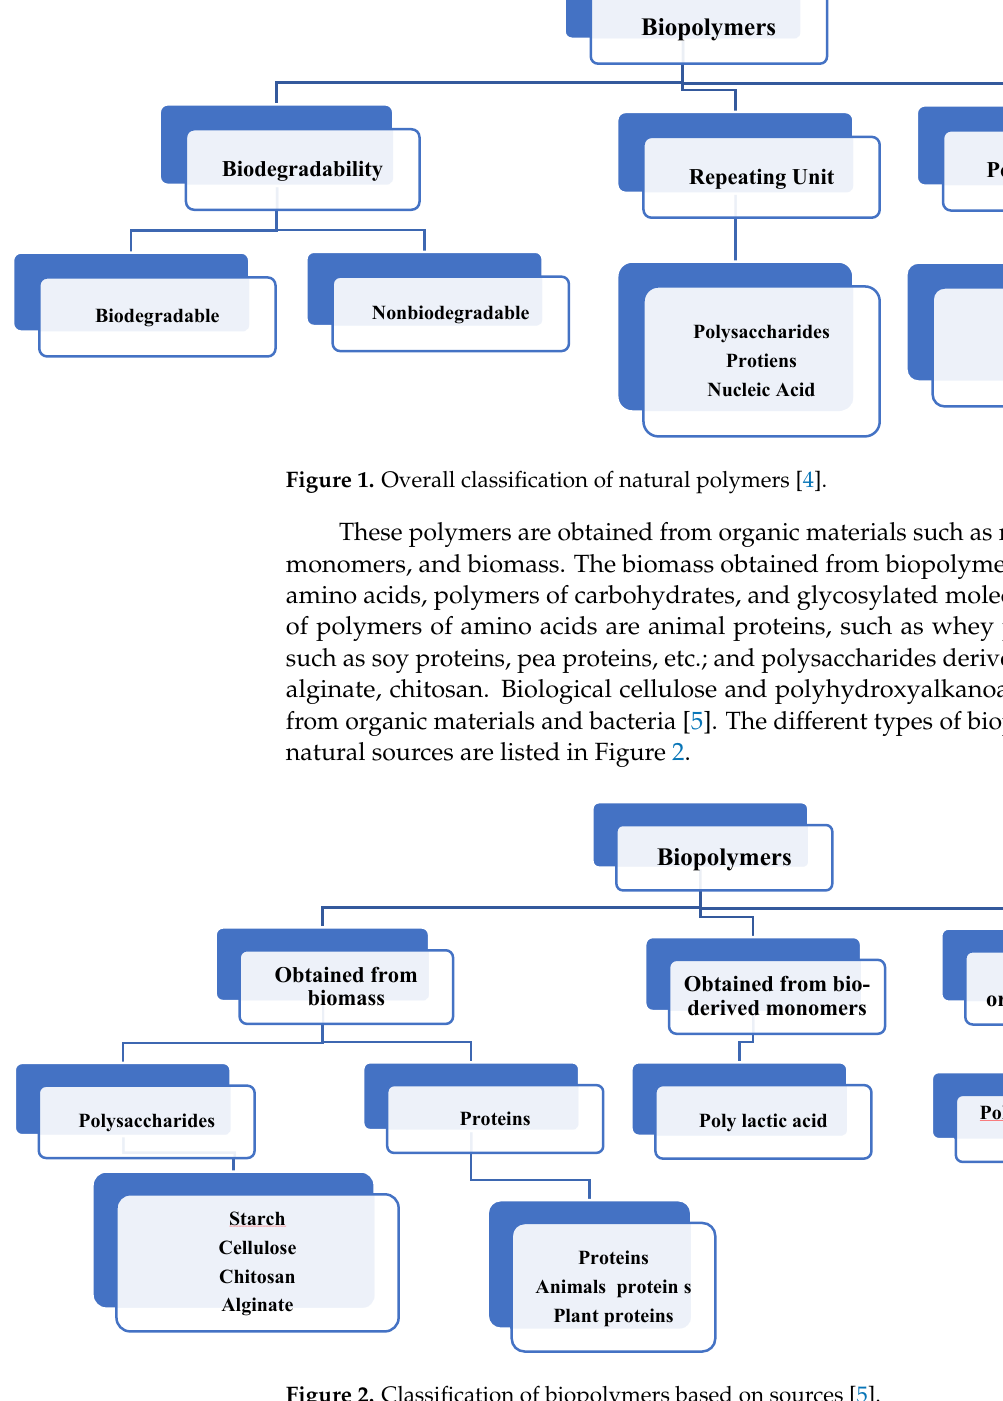
Figure 2. Classification of biopolymers based on sources [5].